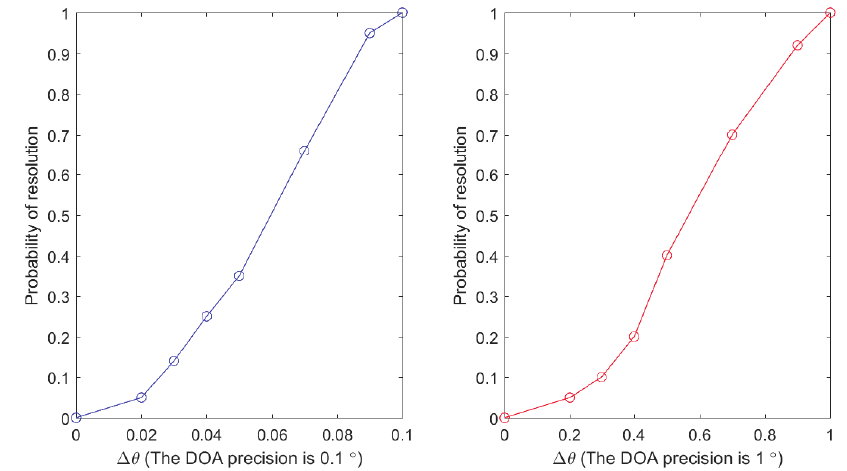
Figure 9. Probability of resolution vs. ∆ θ